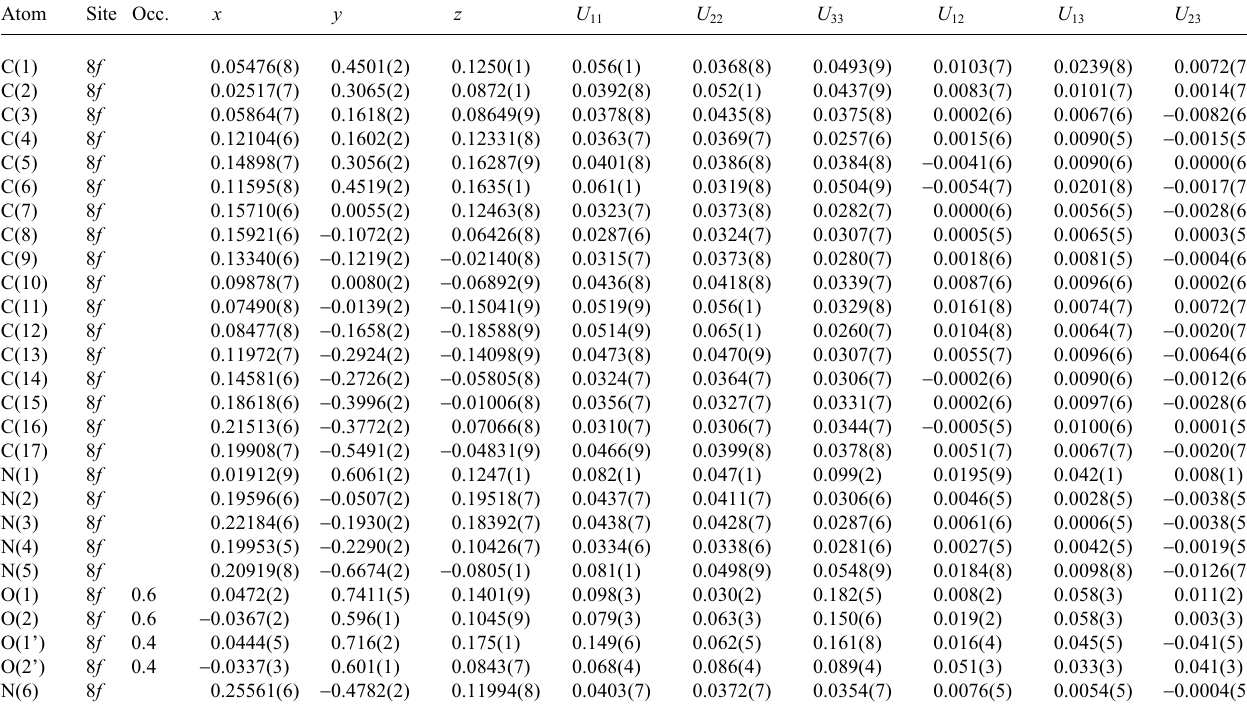
Table 3. Atomic coordinates and displacement parameters (in Å 2 ) . Atom Site